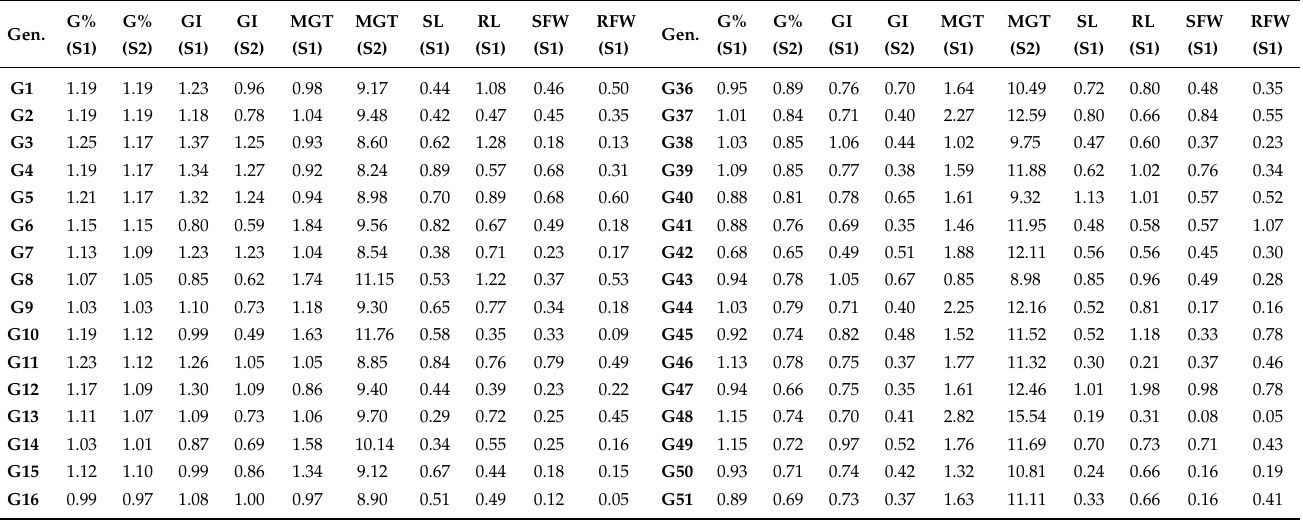
Figure 4. Biplot of principal component analysis between different germination and seedling traits of all barley genotypes evaluated under control and salinity conditions. The vectorial arrows from the origin of scattered biplot indicate positive and negative correlation among traits. G%, GI, MGT, SL, RL, SFW, and RFW indicate germination percentage, germination index, mean germination time, shoot length, root length, shoot fresh weight, and root fresh weight, respectively, under control (C), 100 mM NaCl (S1), and 200 mM NaCl (S2). Table 6. Salt tolerance indices for different germination and seedling traits of 70 barley genotypes (Gen.) under 100 (S1) and 200 (S2) mM